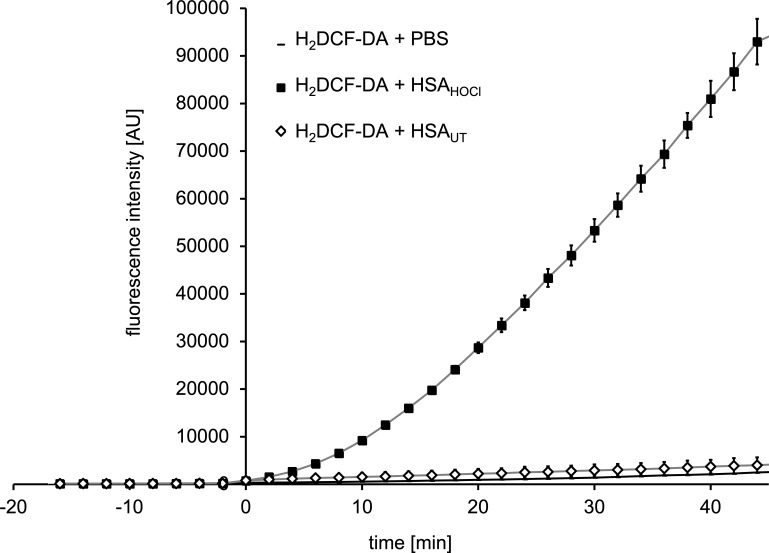
N-chlorinated serum albumin converts 7‘-dichlorodihydrofluorescein diacetate (H2DCF-DA) to the fluorescent 2’, 7’-dichlorofluorescein (DCF).H2DCF-DA is a commonly used fluorescent probe for monitoring intracellular production of reactive oxygen species. H2DCF-DA was preincubated with 1xPBS for 15 min prior to the addition of native HSA (HSA UT), HOCl-modified HSA (HSA HOCl) or buffer (PBS). The fluorescence intensity of DCF was recorded for 45 min.
10.7554/eLife.47395.030Figure 4—figure supplement 1—source data 1.Numerical chemiluminescence plate reader data represented in Figure 4—figure supplement 2.